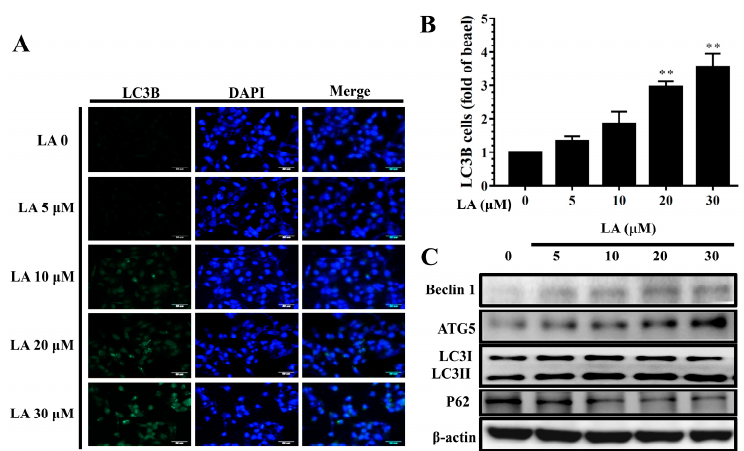
Figure 10. Licochalcone A (LA) regulated autophagy in MDA-MB-231 cells. (A)Fluorescence microscopy showed LC3B expression and the nucleus was stained with DAPI